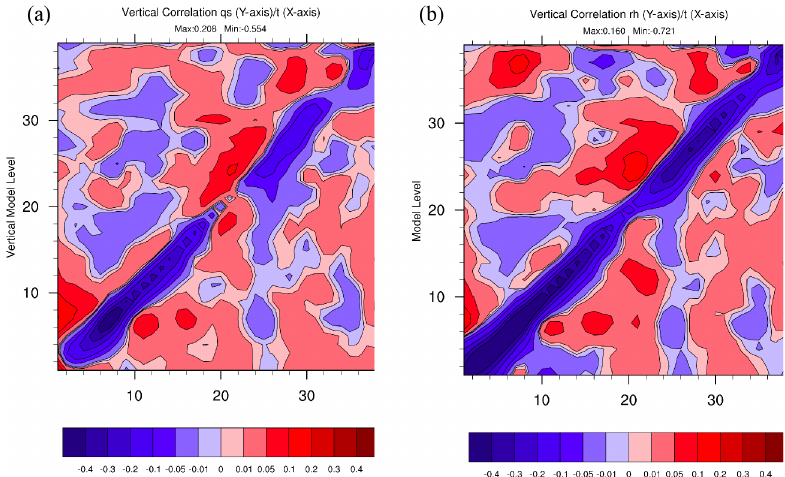
Figure 4. (a) Vertical cross-correlation between temperature ( t ) and specific humidity (qs); (b) vertical cross-correlation between temperature ( t ) and relative humidity (RH); (WRF, res. 15km,